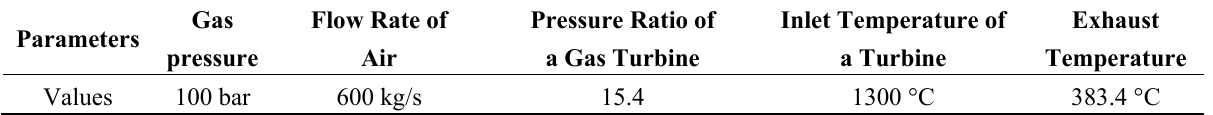
Table 1. Simulation results of the second-generation compressed air energy storage (CAES) system. Parameters